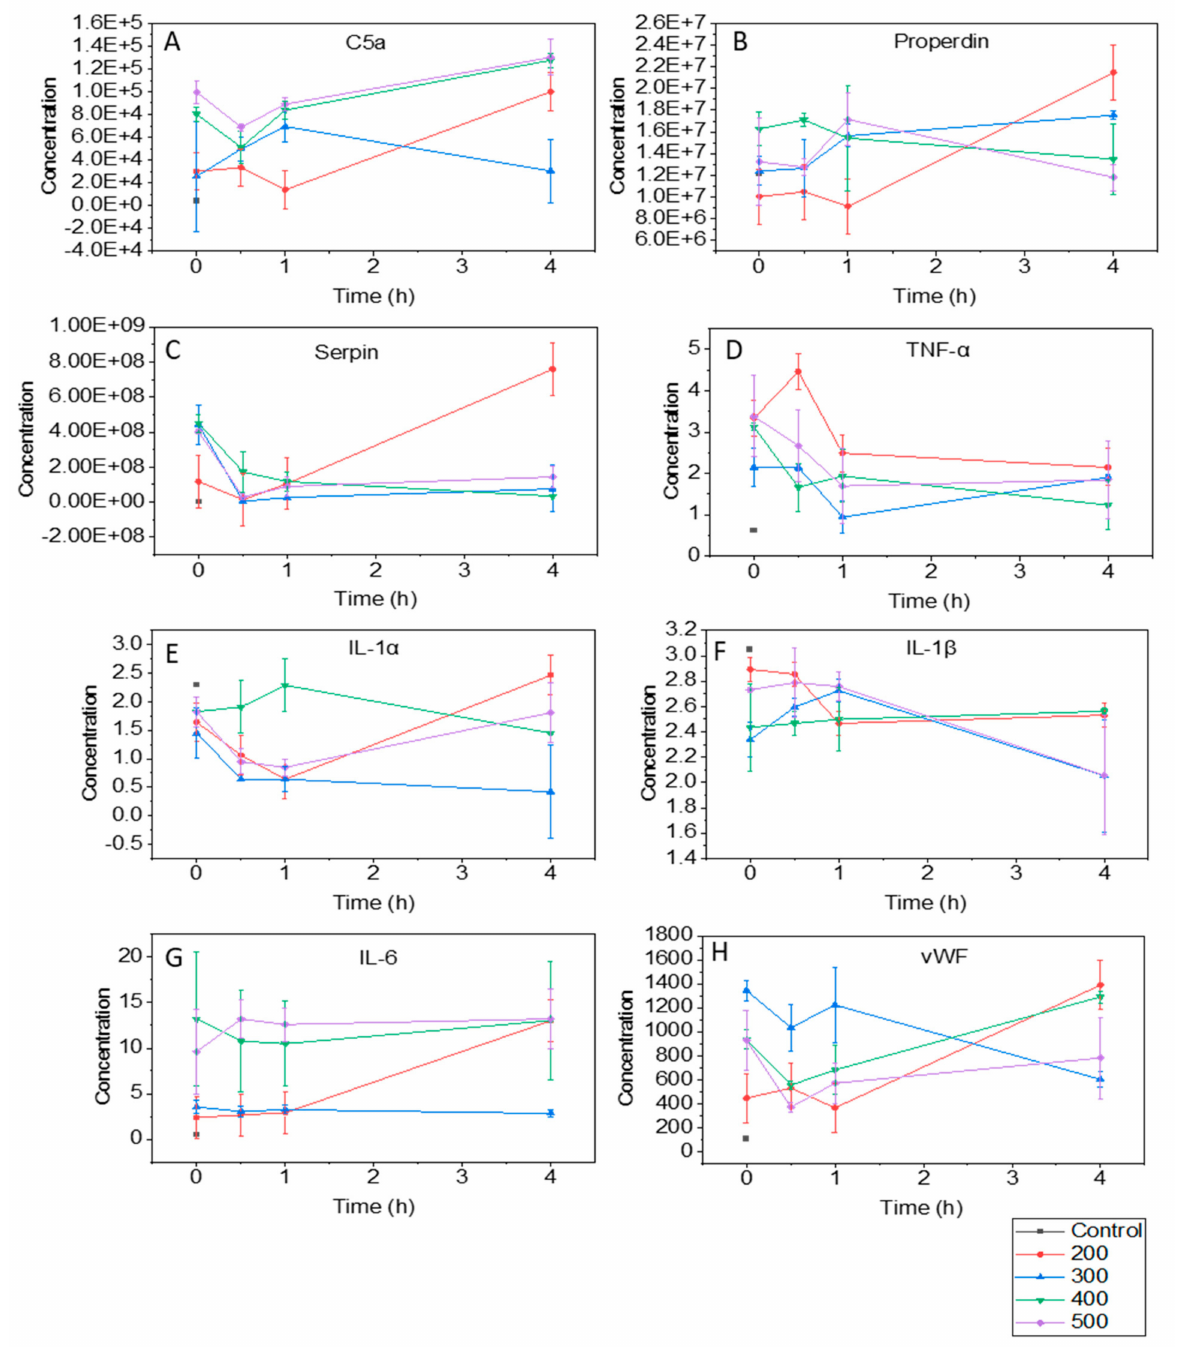
Figure 8. The concentration (pg/ml) of ( A ) C5, ( B ) properdin, ( C ) Serpin, ( D ) TNF- α , ( E ) IL-1 α , ( F ) IL-1 β , ( G ) IL-6, and ( H ) vWF in blood samples collected during dialysis sessions from patients treated with different Qb levels (Qd = 500